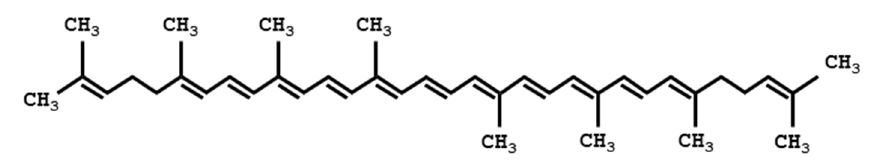
Figure 2. Acyclic C 40 H 56 model structure of a carotenoid molecule.